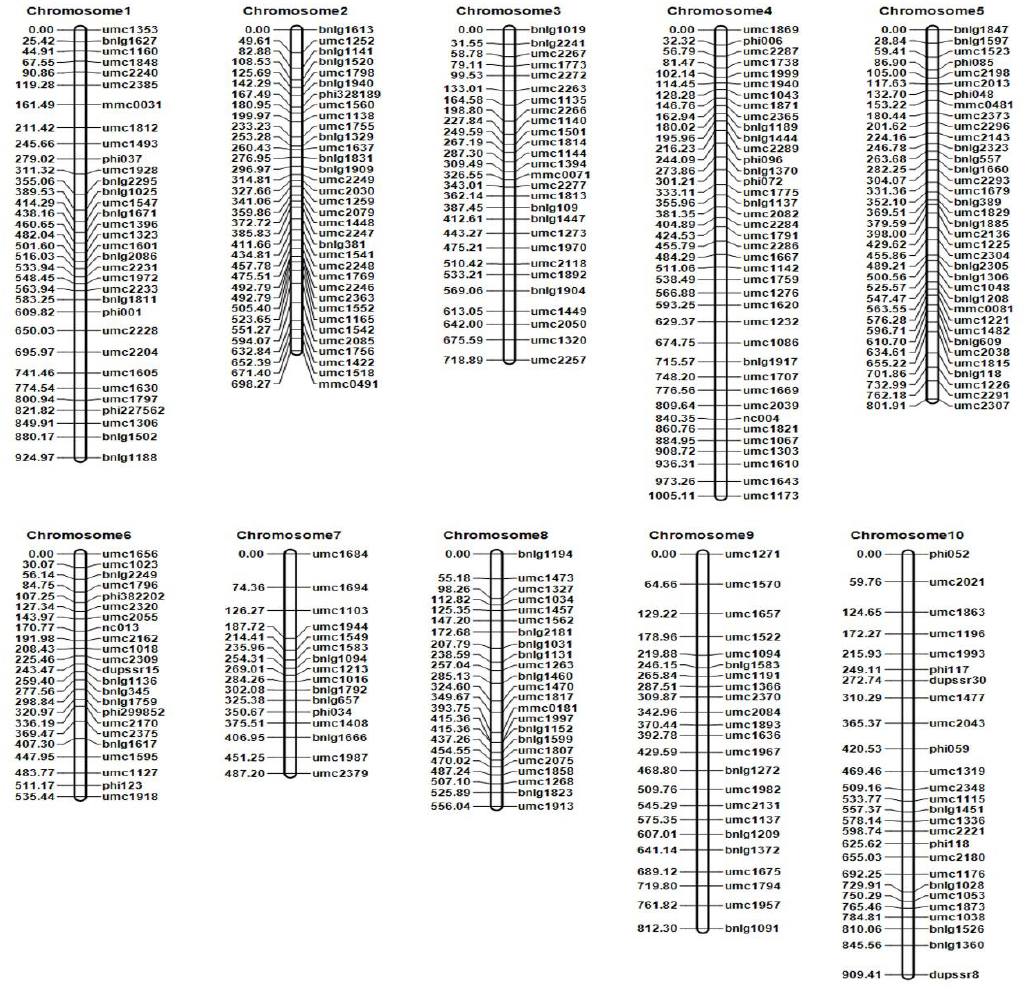
Figure 3. A genetic map of phenotypic indicators of the F 2:3 population. The left side of each chromosome in the figure represents the genetic distance between markers in centimorgans (cM), and the right side shows the SSR markers’ names on the respective chromosome. Note: LOD score represents the LOD value of each QTL, while additive effect represents the additive effect value.